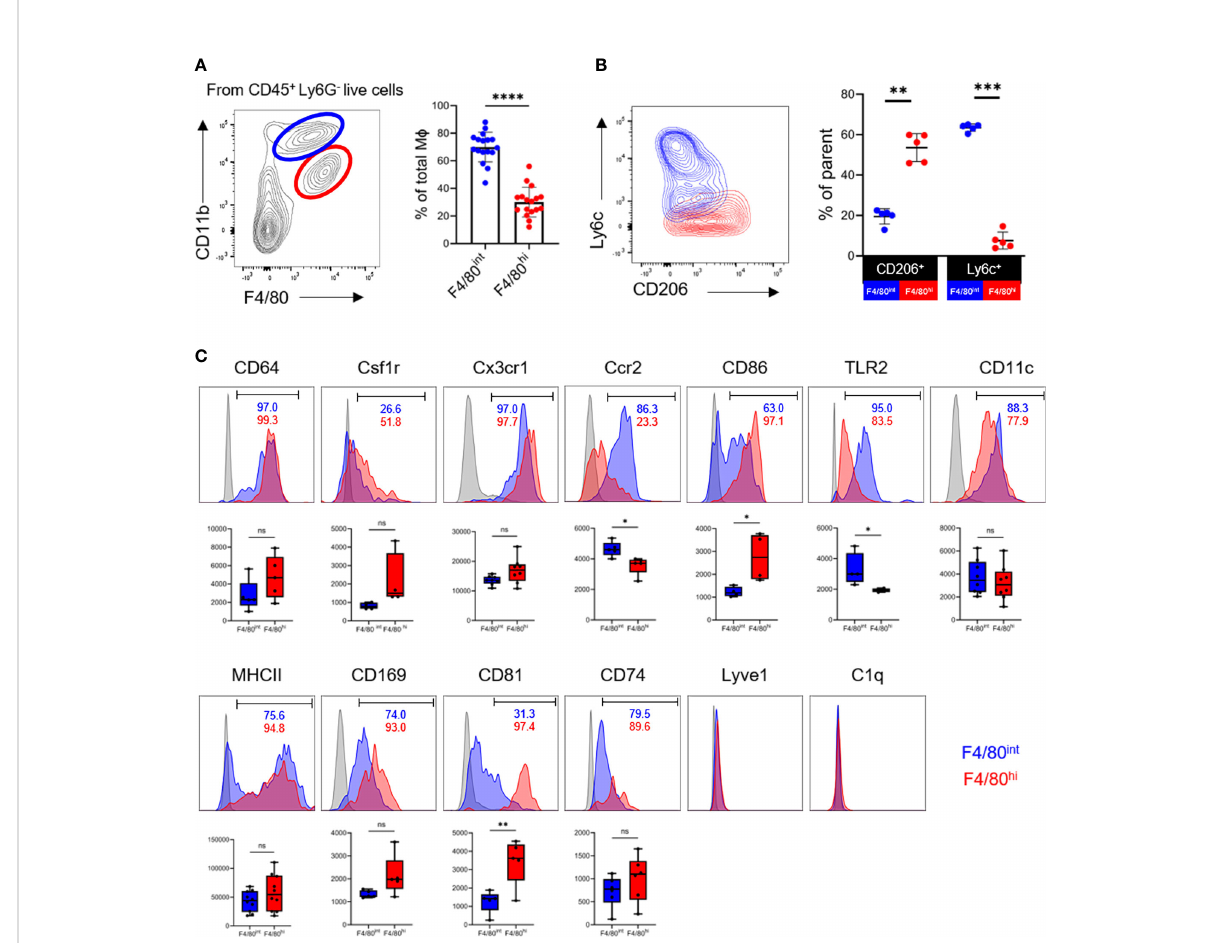
FIGURE 2 Two phenotypically distinct macrophage populations reside in the ovary. (A) The contour plot depicts the gating strategy for macrophages subsets and graphs show the proportion of F4/80 int CD11b hi (blue) and F4/80 hi CD11b int (red) macrophage populations in the ovaries (n=17. Mean ± SEM). (B) Expression of Ly6c and CD206 in two subpopulations of macrophages (n=5. Mean ± SEM). (C) Representative histogram, positivity ratios and mean fl uorescence intensity (MFI) of macrophage surface markers expression. ns, no signi fi cance, *P < 0.05, **P < 0.01, ***P < 0.001, ****P <